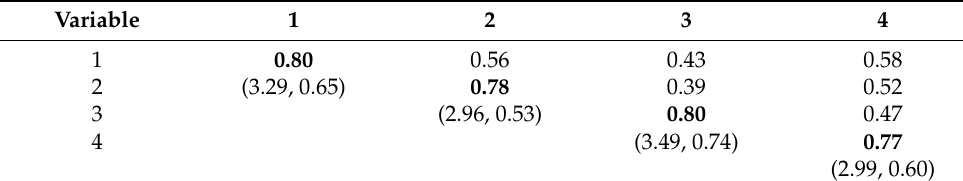
Table 5. Correlations and discriminant